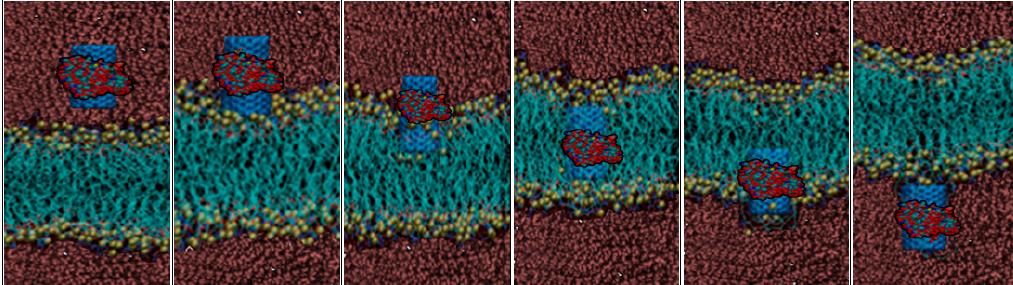
Figure 8. Snapshot of the crossing of functionalized CNT through the membrane. This figure shows the orientation of functionalized CNT while crossing through the membrane.